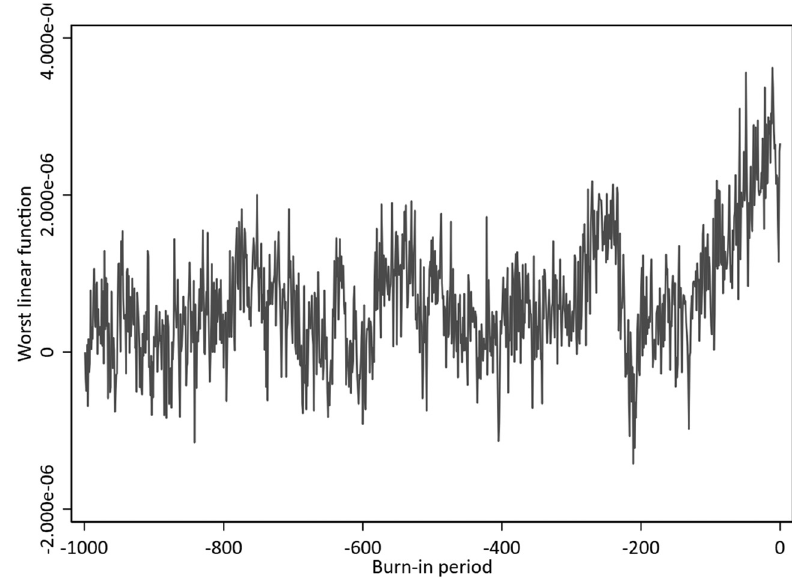
Figure A3: Time - series plot of WLF ( Table 4/Extended data ) .